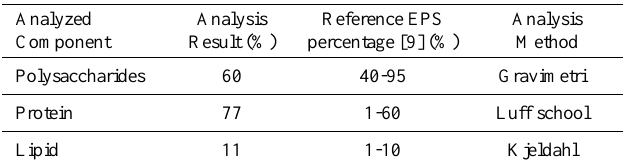
Table 2. Analysis Result of EPS Composition